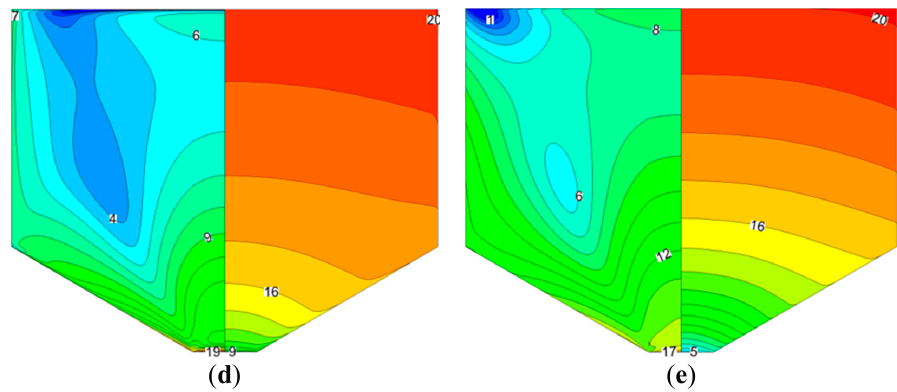
Figure 5. Temperature ( right ) and thermal stress ( left ) distributions in the crystal with different coefficient absorptions: ( a ) a = 0 m − 1 ; ( b ) a = 0.19 m − 1 ; ( c ) a = 10 m − 1 ; ( d ) a = 79 m − 1 ; and ( e ) a = 500 m − 1 . The variations of radiation and conduction heat transfer rates at the surface B with absorption coefficient are presented in Figure 6. The radiation heat transfer rate monotonically decreases with the increasing absorption coefficients due to the decreasing ability of internal radiation heat transfer, while the conduction heat transfer rate first increases and then decreases as the absorption coefficient increases. The variation of the conduction heat transfer rate as a function of absorption coefficient is understood in the following manner. When the absorption coefficient is relatively small, the increasing conduction heat rate is a result of more radiation heat absorbed by the crystal with the increasing absorption coefficient. As the absorption coefficient further increases, internal radiation strongly weakens, leading to less radiation heat to be absorbed by the crystal, so that the conduction heat transfer rate decreases.